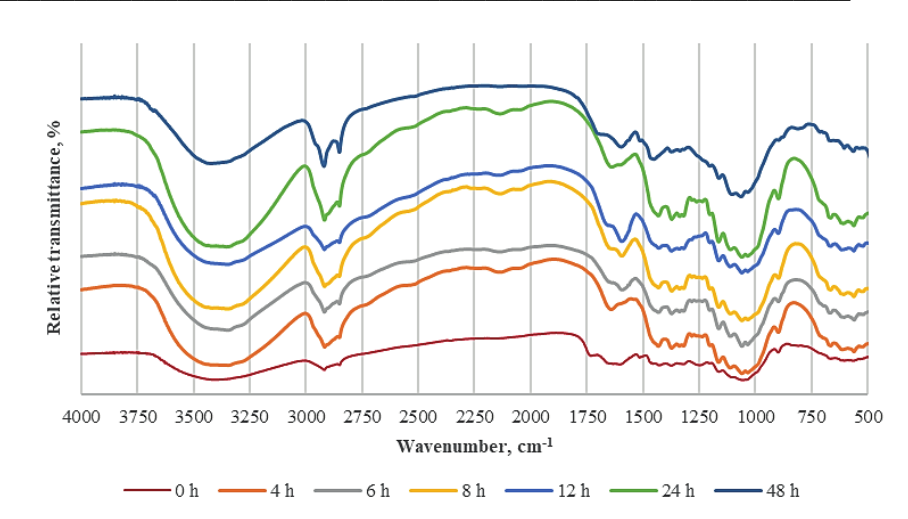
Fig. 4. FTIR spectra of hydrochar samples depending on the duration of hydrothermal treatment duration (wheat straw biomass, 200 °C, 24 h). Comparing behaviour of different types of biomasses in the HTC process, we found (Fig. 5)